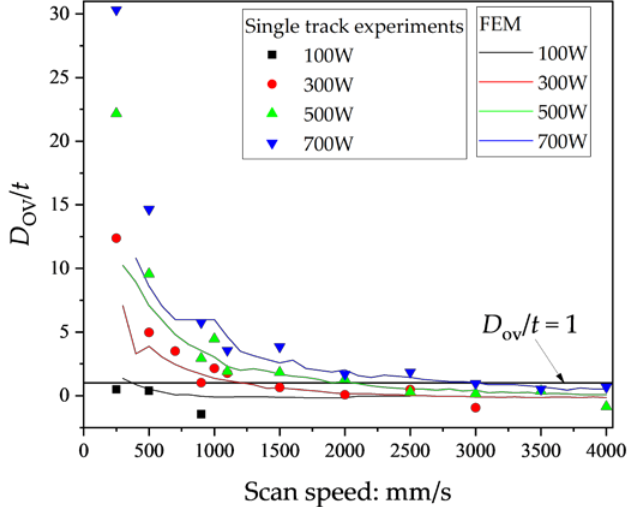
Figure 11. Comparison of D ov / t assuming that h = 100 μm obtained from single-track experiments and the FEM analysis.